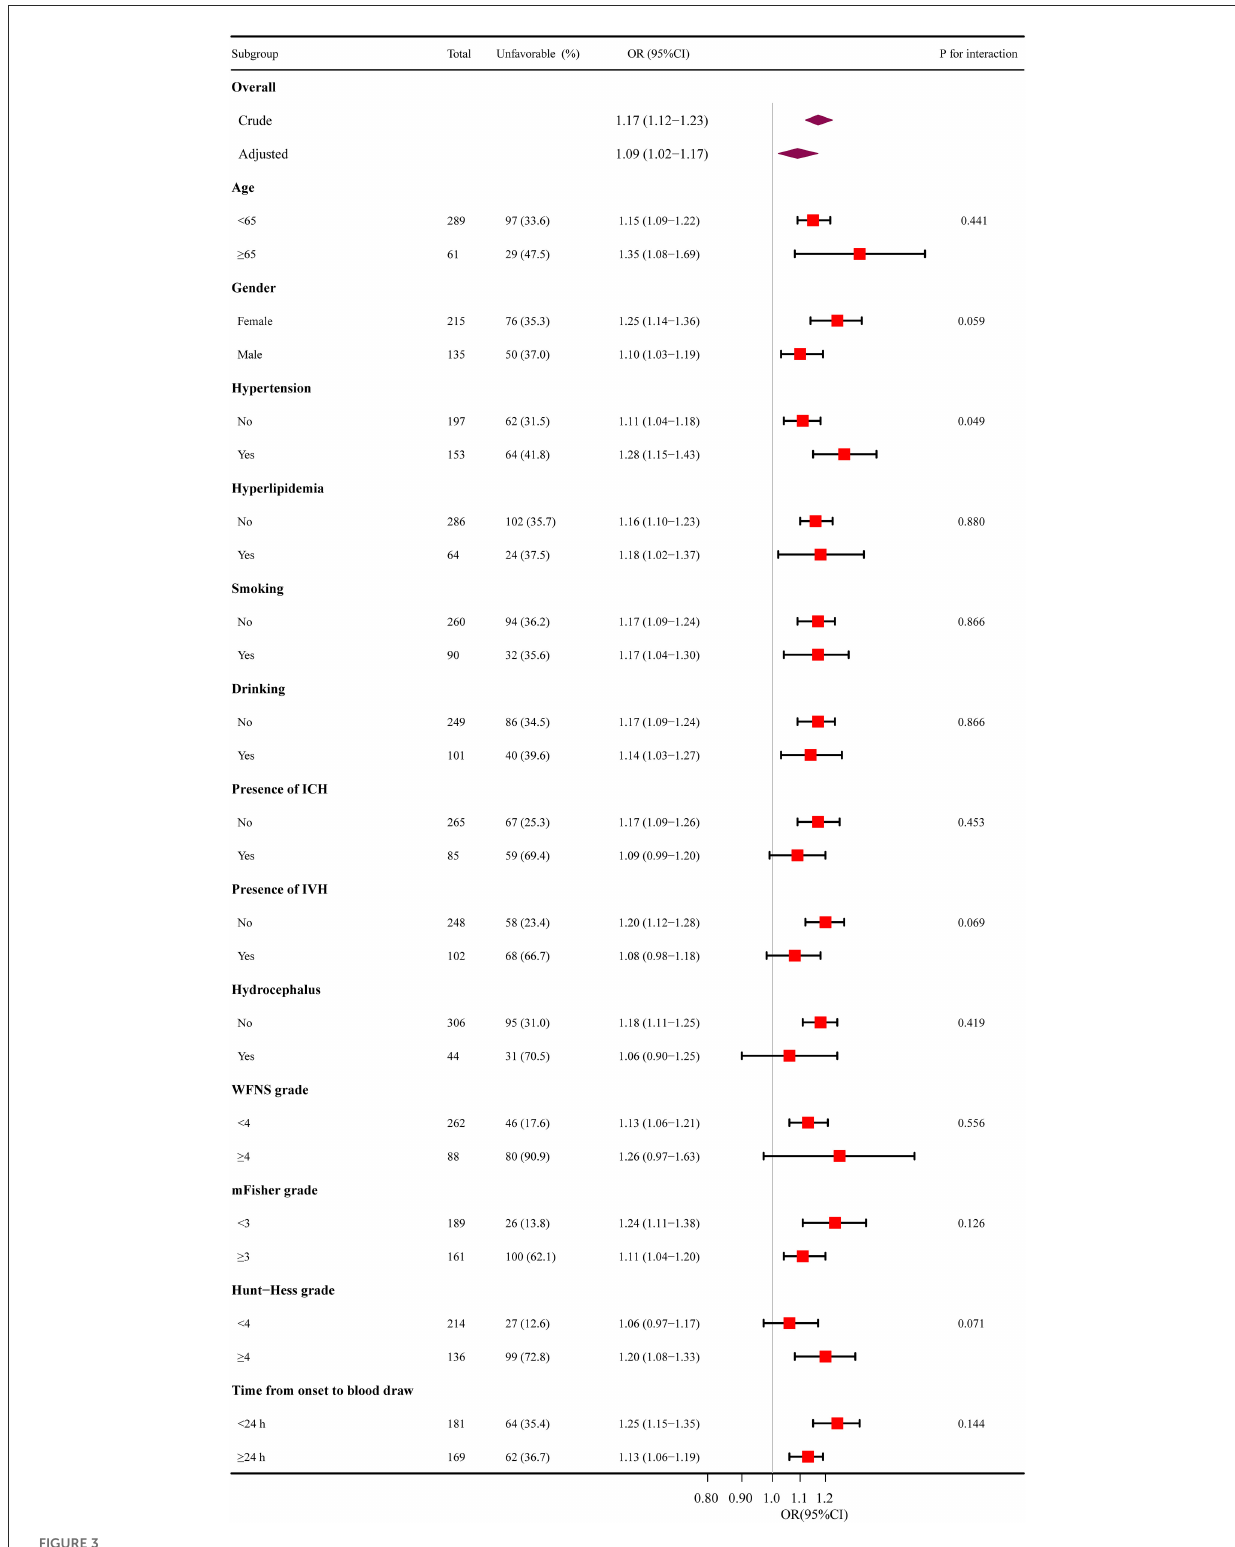
FIGURE3 The relationship between SIRI and functional outcomes in subgroup analysis. SIRI, systemic inflammation response index; ICH, intracerebral hemorrhage; IVH, intraventricular hemorrhage; WFNS, World Federation of Neurosurgical Societies; mFisher, modified Fisher; OR, odds ratio; CI, confidence